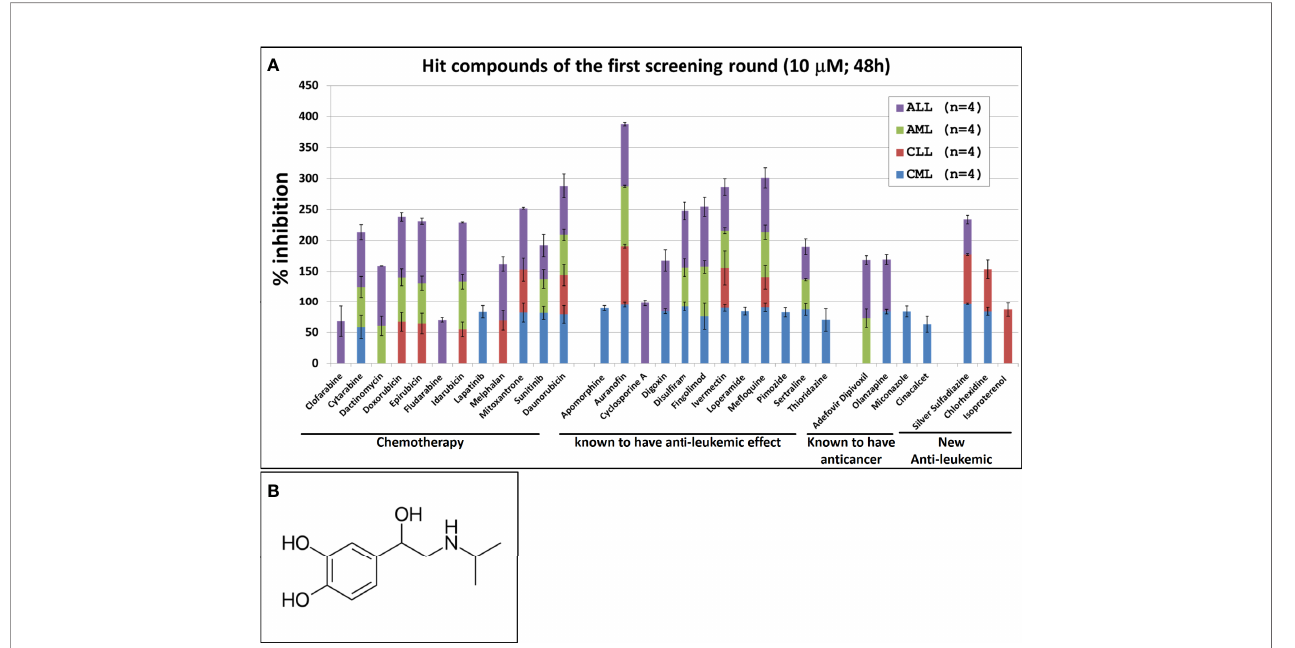
FIGURE 1 | Hit compounds of the fi rst round of screening. (A) List of Hit compounds selected in the phenotypic single-dose (10µM) HTS campaigns. Primary leukemic cells used in this screening were isolated from blood samples derived from patients with Acute Myeloid Leukemia (AML, n=4), Acute Lymphocytic Leukemia (ALL, n=4), Chronic Lymphoid Leukemia (CLL, n=4), Chronic Myeloid Leukemia (CML, n=4) and from four healthy donors (n=4). The overall screening results are displayed and expressed as meanof inhibition ±SD and normalized to DMSO (100%). (B) Chemical structure of